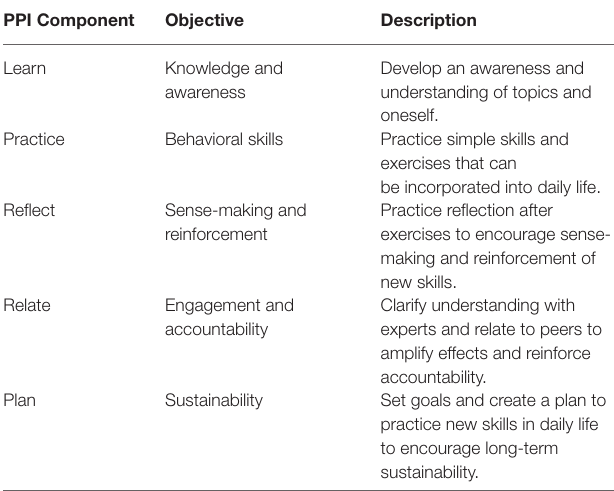
TABLE 5 | Five components that can be incorporated into PPI